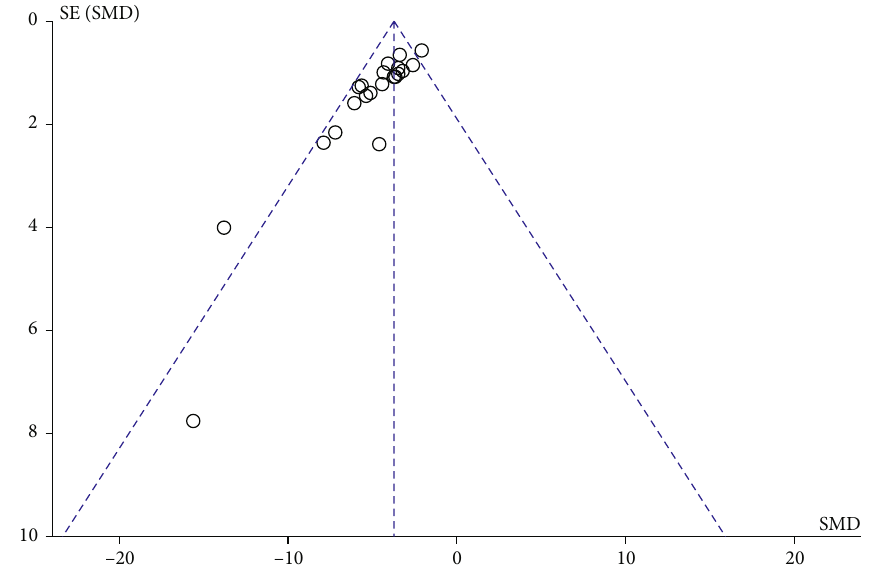
Figure 10: The funnel plot of the cerebral infarction volume in the included